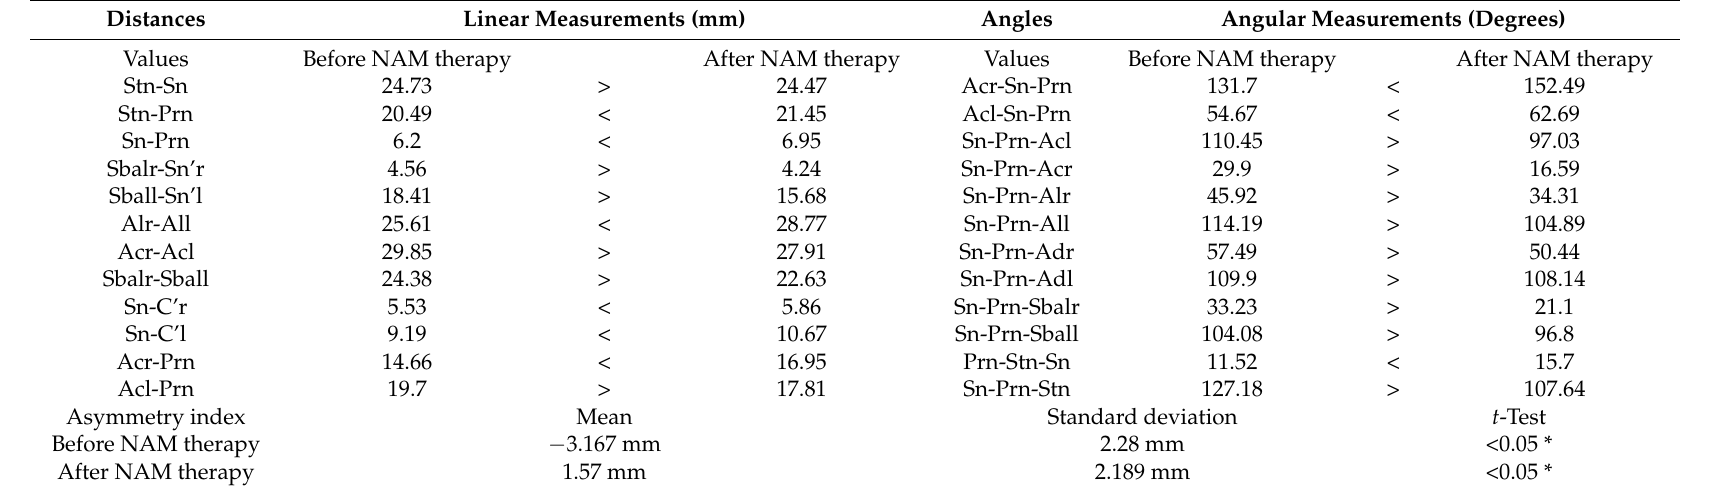
Table 1. Two-dimensional face measures and asymmetry